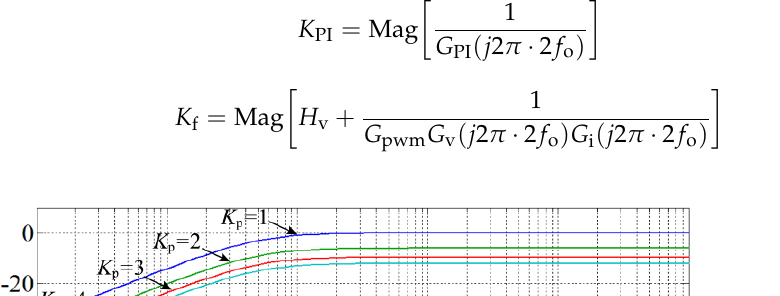
PI ( s ) with different f L .